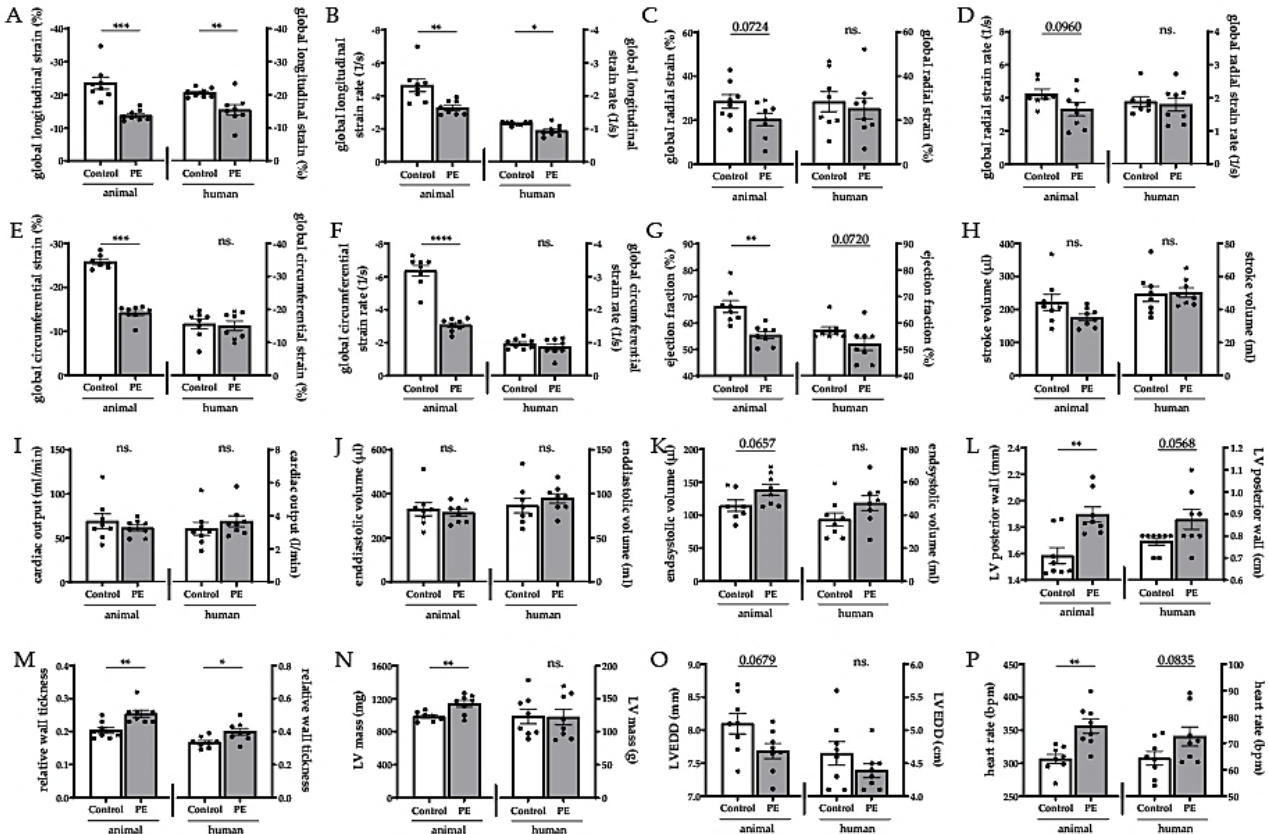
Figure 2. The transgenic rat model simulates cardiac alterations of a human preeclamptic pregnancy. Global longitudinal strain ( A ) and global longitudinal strain rate ( B ) were decreased after preeclampsia (PE). Global radial strain ( C ) and the corresponding strain rate ( D ) were not altered after PE. Global circumferential strain ( E ) and global circumferential strain rate ( F ) were reduced in the post-PE animals but not in the human cohort. Ejection fraction was reduced in animals and showed the same trend in the human PE data ( G ). Stroke volume ( H ), cardiac output ( I ), end-diastolic ( J ), and end-systolic volume ( K ) were not altered in either species after PE. Left ventricle (LV) posterior wall ( L ) and relative wall thickness ( M ) were increased due to PE in both species. LV mass ( N ) was only increased in the post-PE animals. LV end-diastolic diameter ( O ) was unaltered. Heart rate was higher in PE animals and showed increasing trends in humans ( P ). Mean values ± SEM, unpaired students t-test, ns. Non-significant, * p < 0.05, ** p < 0.01, *** p < 0.001, **** p < 0.0001.